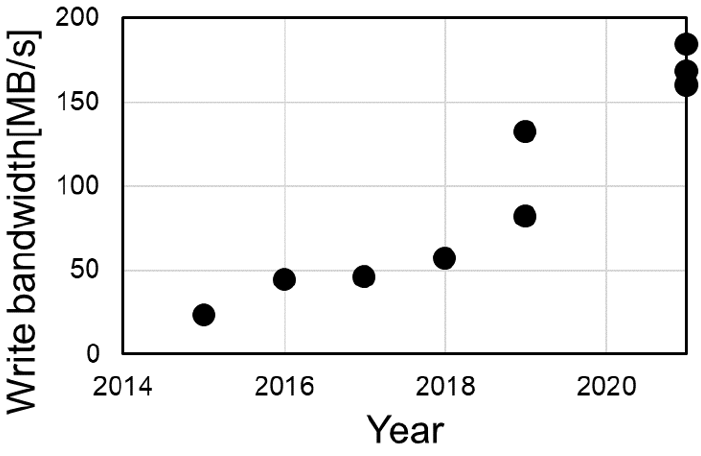
Figure 16. TLC write bandwidth trend reported in ISSCC conferences.